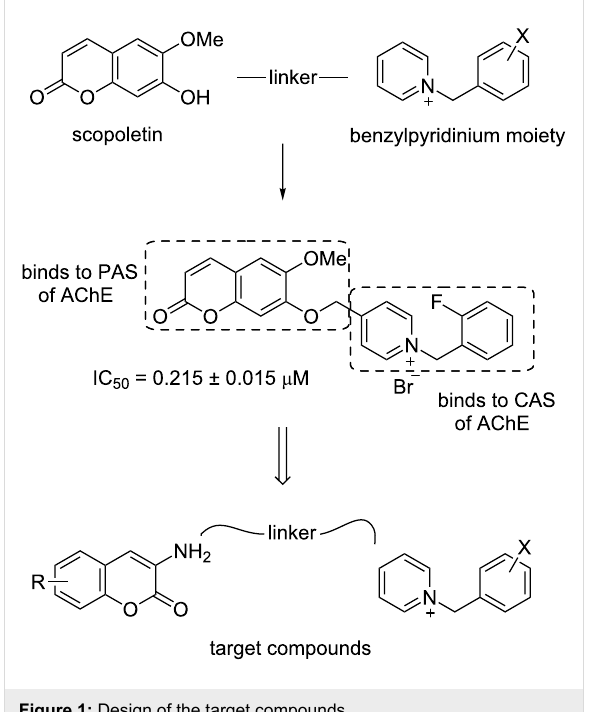
Figure 1: Design of the target